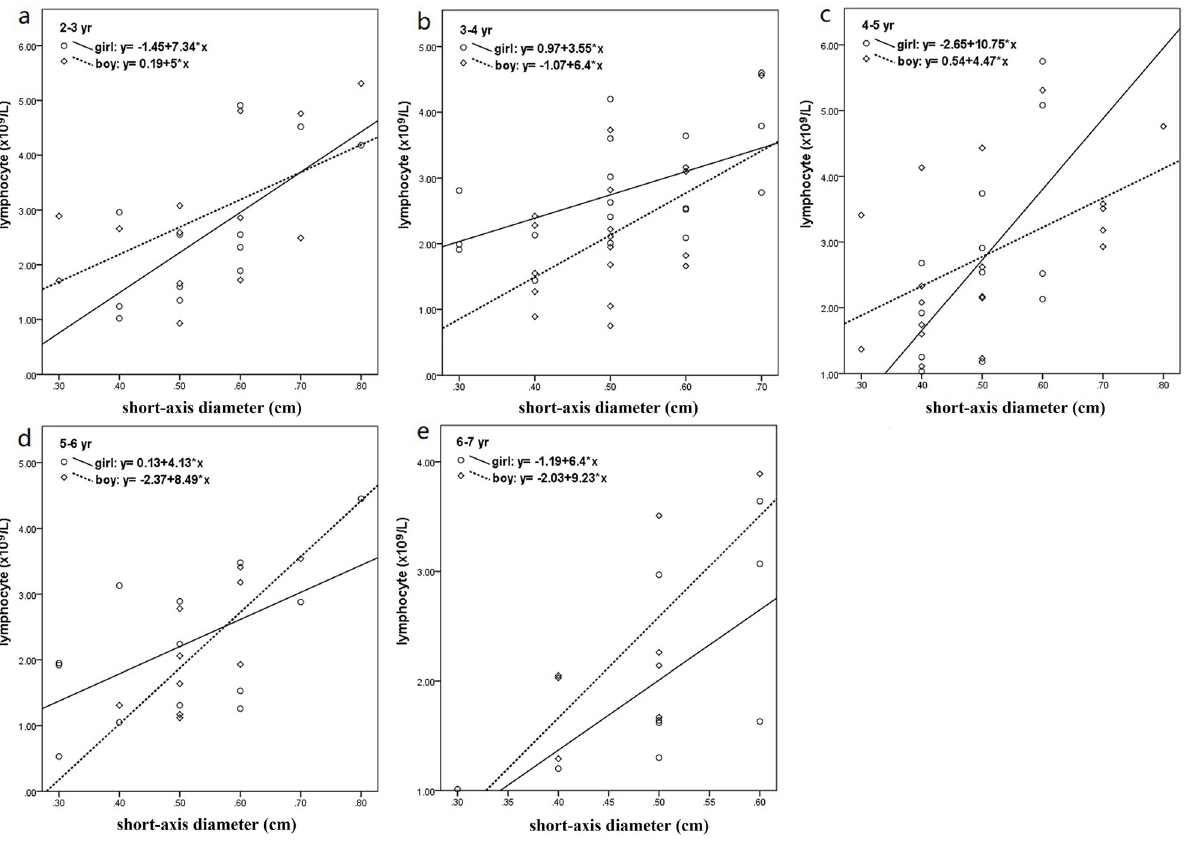
Fig 2. Results of fitting lines of lymphocyte counts with the short-axis diameters of the largest mesenteric lymph nodes for 2–3 yr group (a), 3–4 yr group (b), 4–5 yr group (c), 5–6 yr group (d), 6–7 yr group (e).